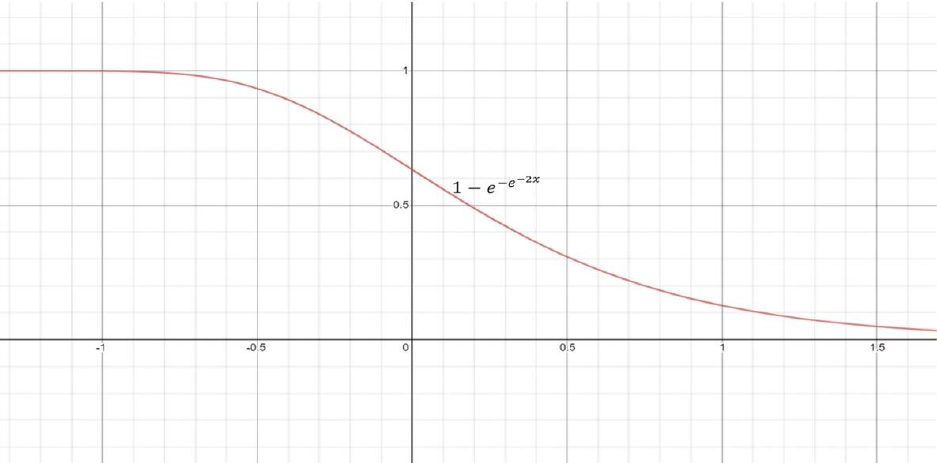
Figure 8. Showing the re-parameterized Gompertz function.